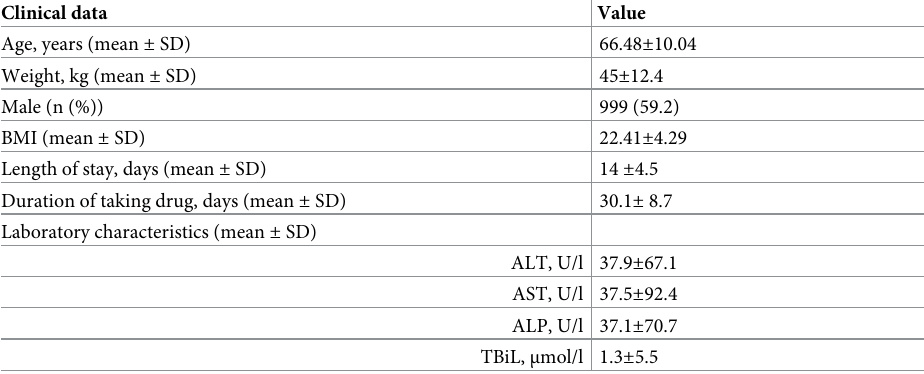
Table 1. Characteristics of study participants (n =